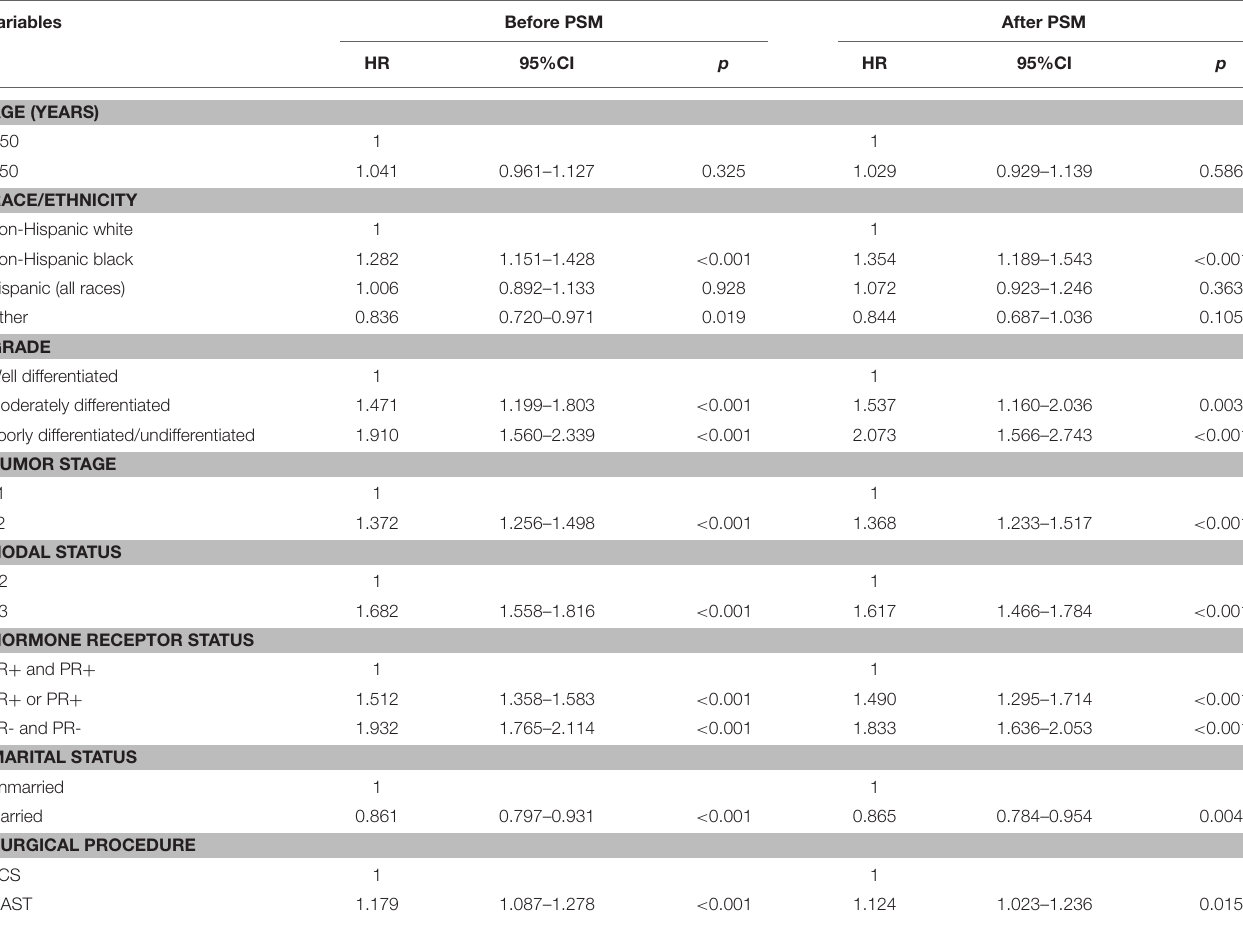
TABLE 2 | Multivariate analysis of prognostic factors for BCSS before and after PSM.